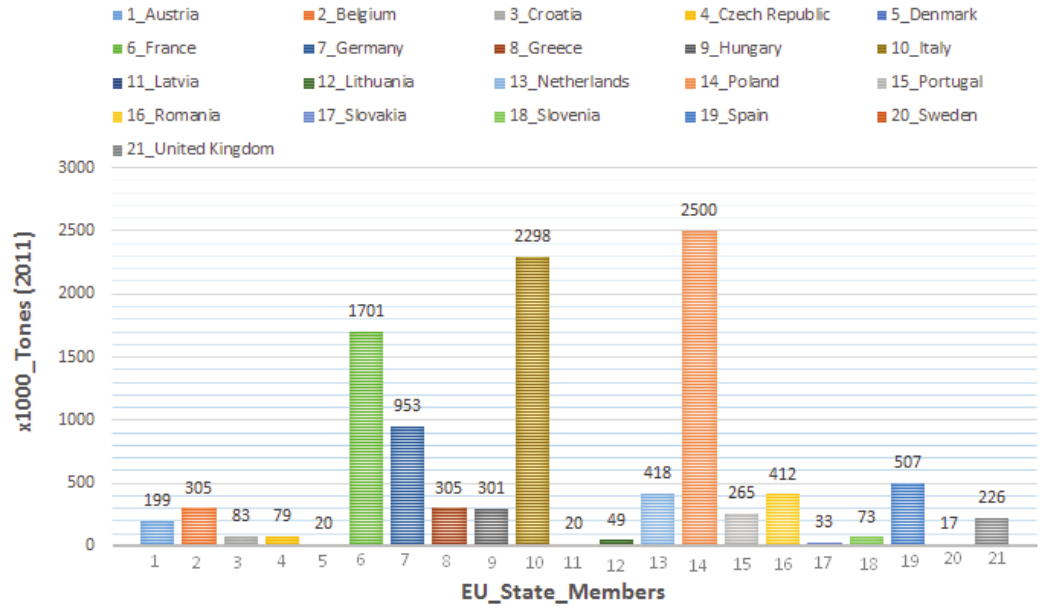
Figure 2 Apple production by country among the 27 EU state members 2011 (source: FAOSTAT,